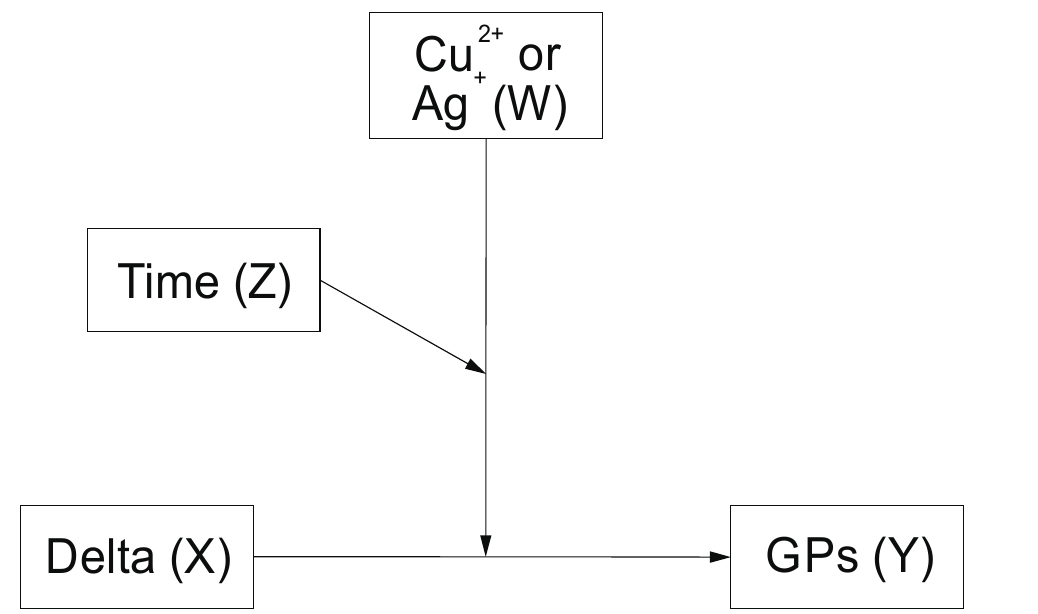
Figure 3. Schematic illustration of conditional moderation model. X is a Delta (DM-DNM), Y is the outcome variable reflecting the number of green plants regenerated per 100 anthers (GPs), W states for Cu 2+ or Ag + ions conditional on Time of in vitro tissue culture (Z).